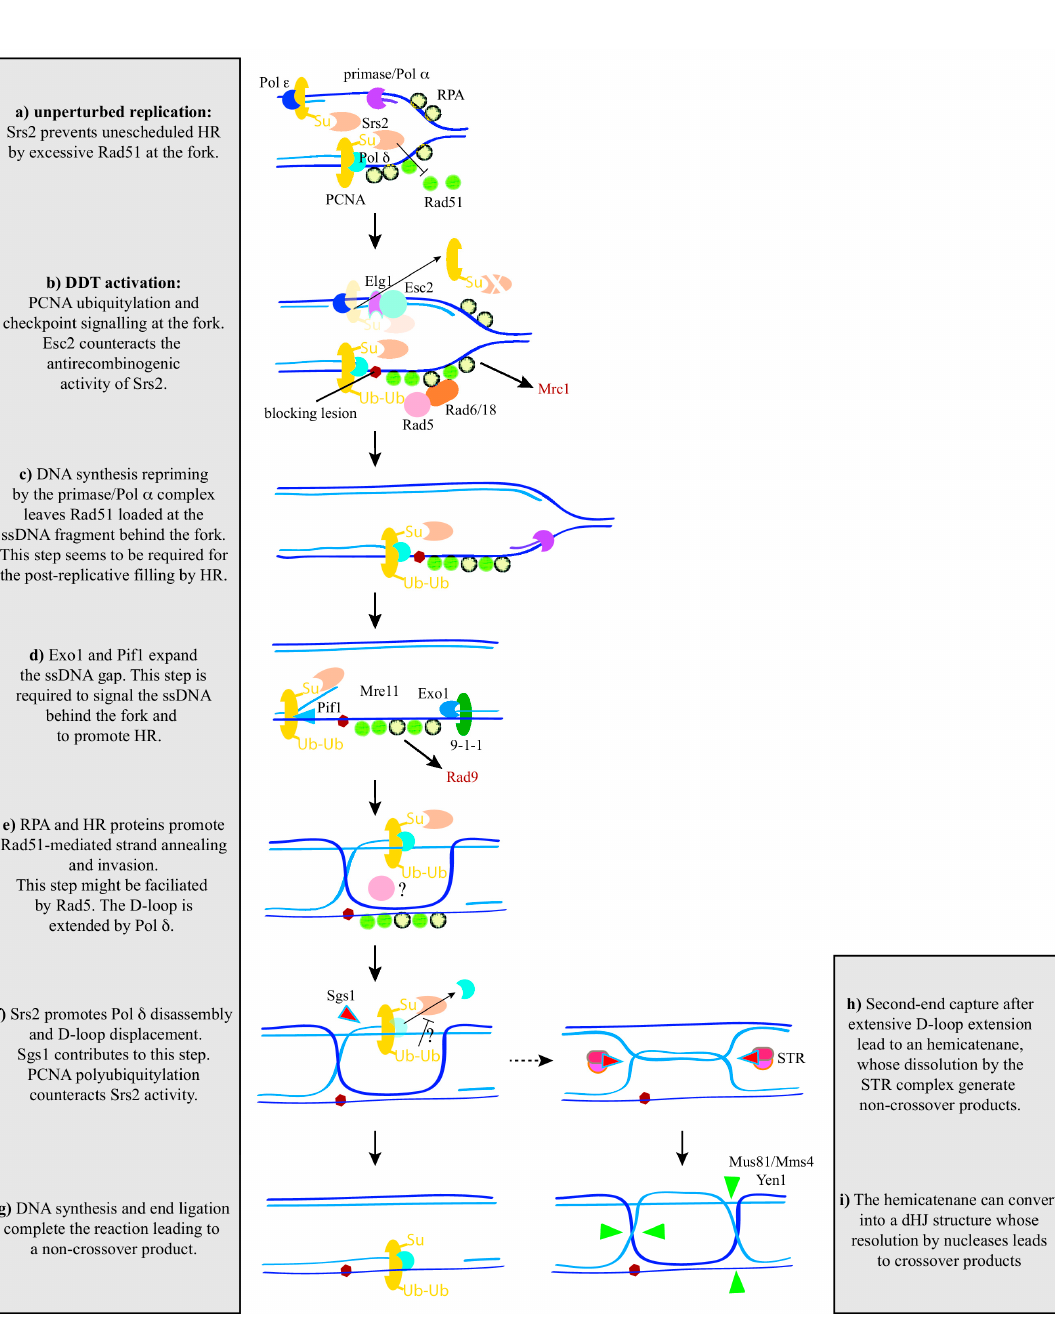
Figure 3. A unifying model for recombination activities at and behind the fork in yeast. See text for details. PCNA: proliferating cell nuclear antigen; RPA: replication protein details. PCNA: proliferating cell nuclear antigen; RPA: replication protein A